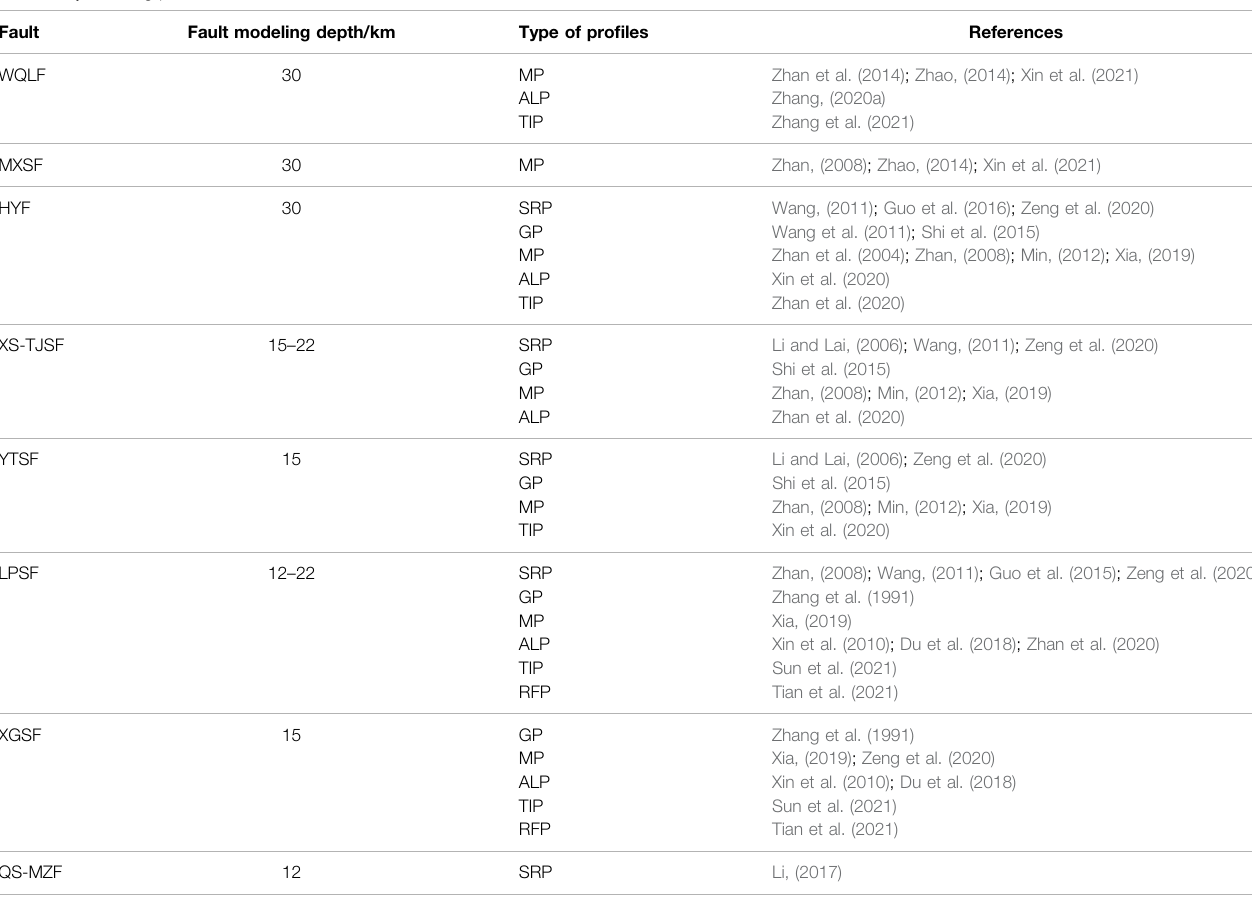
TABLE 1 | Modeling pro fi les in the V3